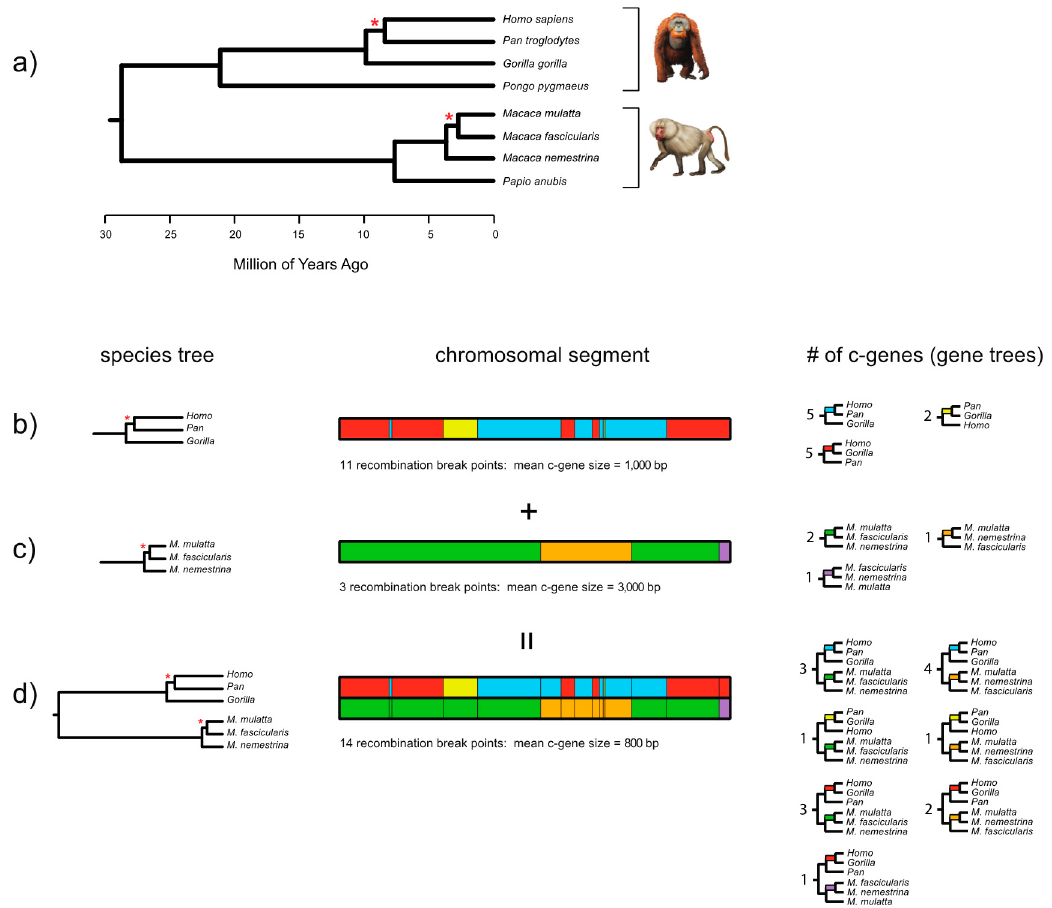
Figure 2. Results of four-gamete test (FGT) for the ARMC3 gene (~120.1 kb alignment). The FGT was applied separately to two subtrees of primates (panel a )—four hominids ( Homo, Pan, Gorilla, Pongo ) and four cercopithecids (3 Macaca spp., Papio ). Primate relationships are as in Springer et al. [71]. The FGT was applied to the entire ARMC3 gene from start codon to stop codon, but the results are only illustrated for the first 12 kb of the alignment. Recombination breakpoints and c-gene trees are shown for hominids (panel b ) and Macaca spp. (panel c ). In both cases there are three possible topologies, all of which are represented by one or more c-gene trees (the outgroups Pongo and Papio are not shown). Panel ( d ) shows the results of the recombination ratchet, where overlay of 11 recombination breakpoints for hominids and three recombination breakpoints for Macaca results in 14 recombination breakpoints and 15 c-genes for the 12 kb alignment (panel d ). Among the nine topologies that are possible for the two subtrees of three taxa, seven are represented among the 15 c-gene trees (panel d ). Paintings of Pongo and Papio by Carl Buell.